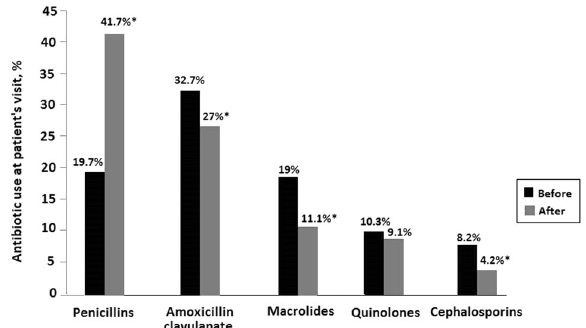
Fig. 1 Percentage of use of the different antibiotic classes in relation to overall use of antibiotics before and after the educational intervention at the time at which the patient was evaluated by the primary care physician. * P < 0.01 for the comparison before and after the intervention ( χ 2